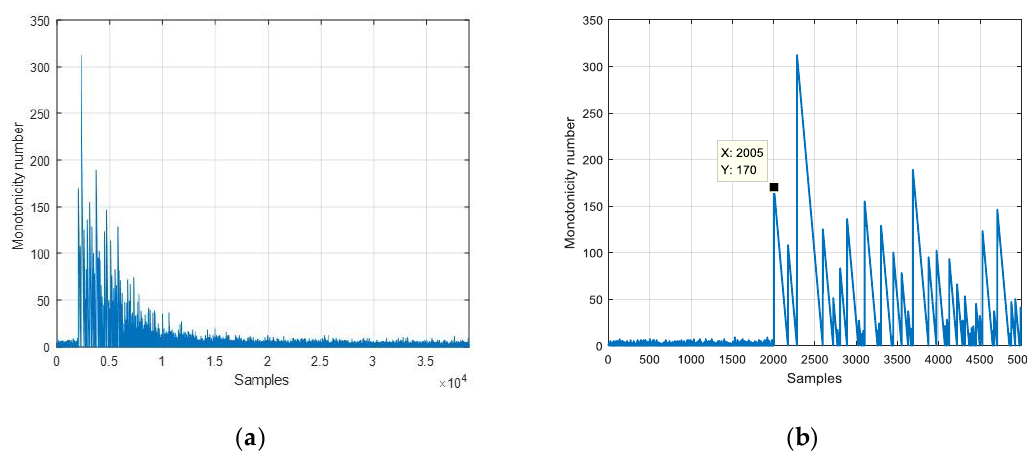
Figure 9. Monotonicity number of the averaged response data: ( a ) in the scale of 39,000 samples, ( b ) in the scale of 5000 samples.